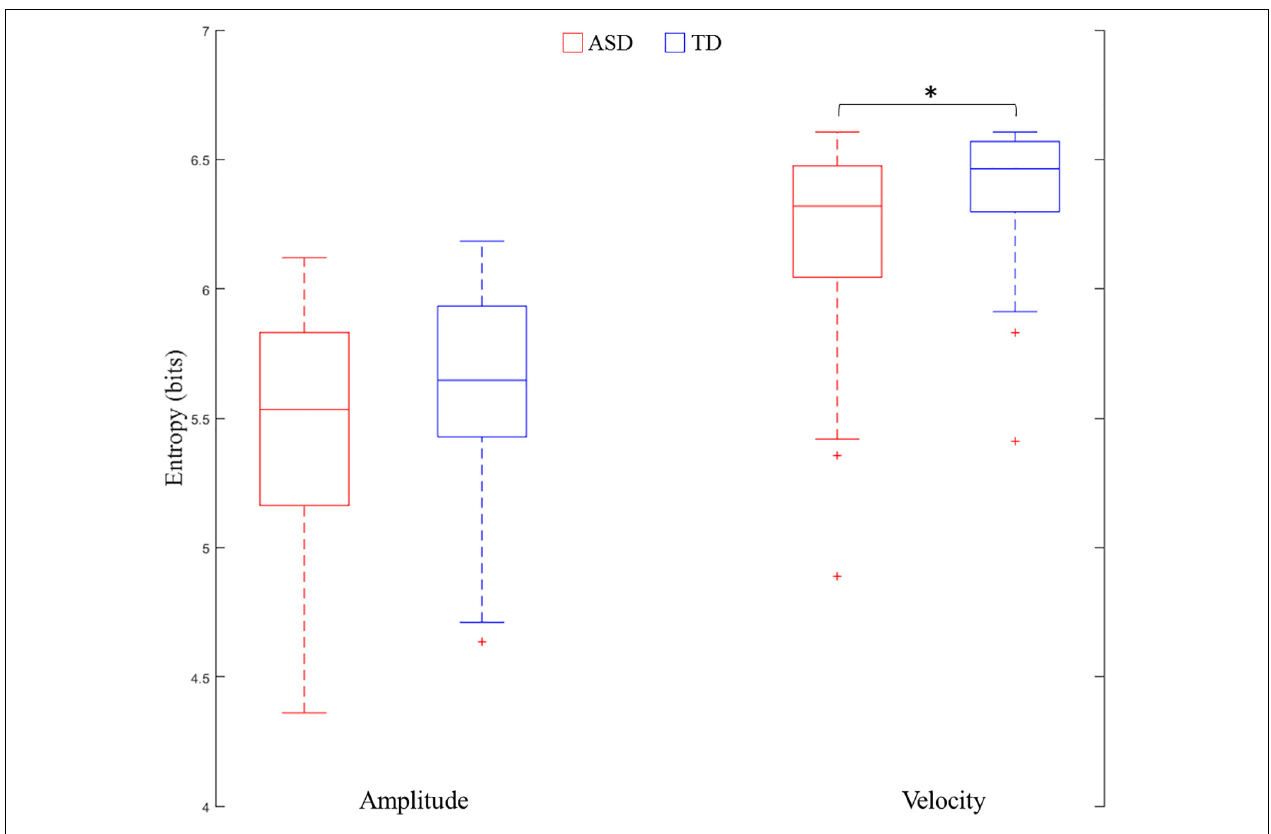
FIGURE 3 | Comparisons of entropy of amplitude and velocity between ASD and TD. ∗ means p < 0.05.